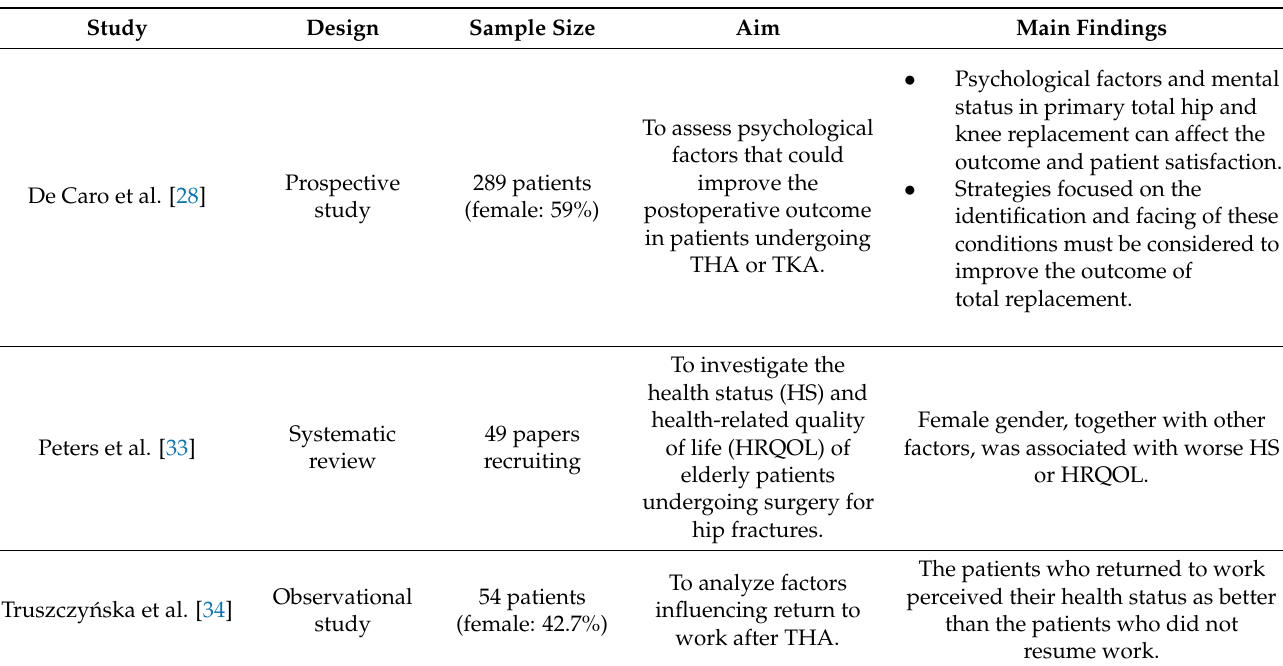
Table 4. Studies showing the role of psychological status and daily functional